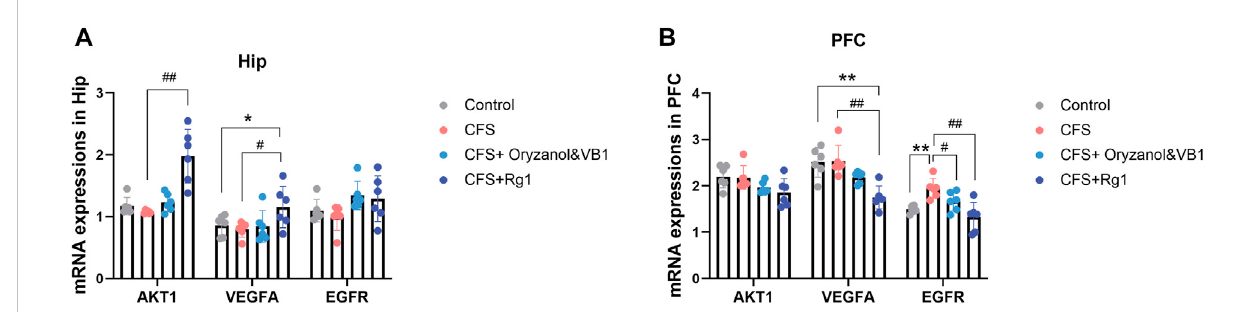
FIGURE 9 (A) RelativemRNAexpressionofAKT1,VEGFAandEGFRinthehippocampus(Hip)after2weeksoftreatment. (B) RelativemRNAexpressionofAKT1, VEGFAandEGFRintheprefrontalcortex(PFC)after2 weeksoftreatment.Dataaremean±standarddeviation,n=6.* p < 0.05,** p < 0.01versusControl group; # p < 0.05, ## p < 0.01 versus CFS group.